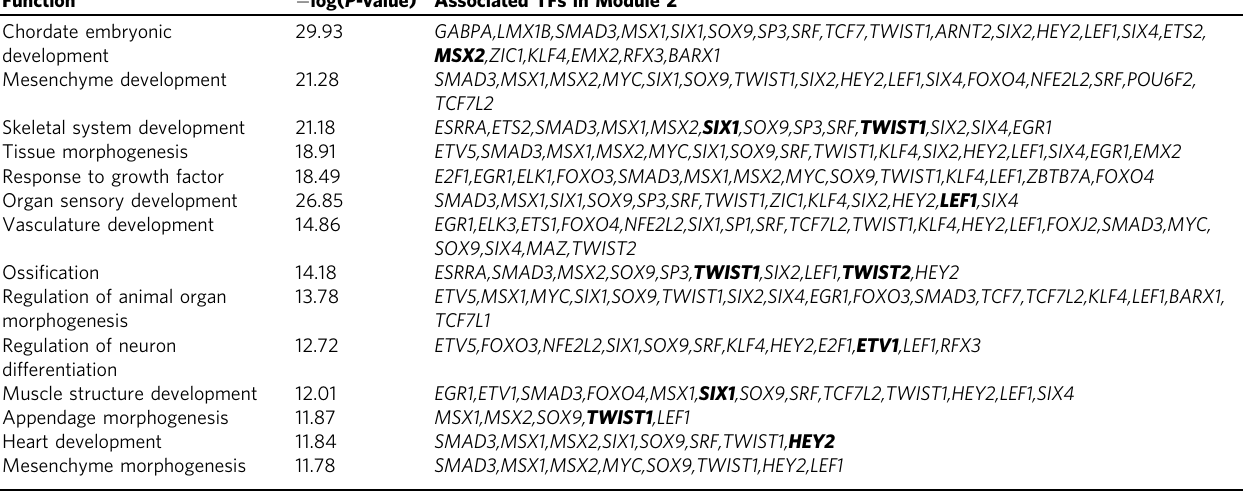
Table 2 TFs in Module 2 are enriched in CNCC-speci fi c developmental